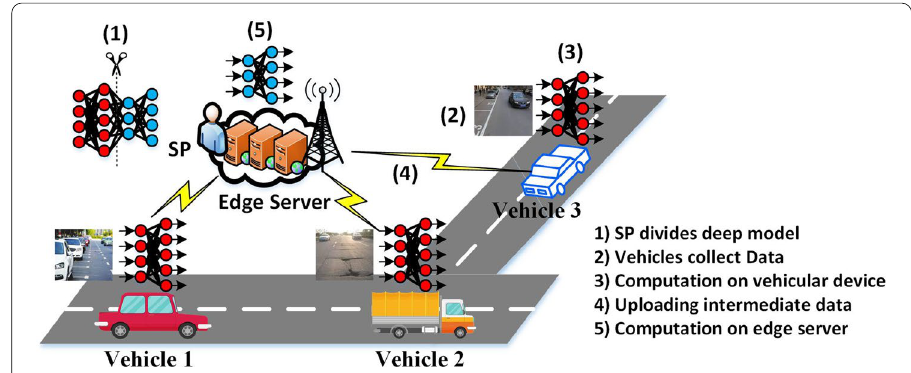
Fig. 1 Device-edge co-inference paradigm for VCS